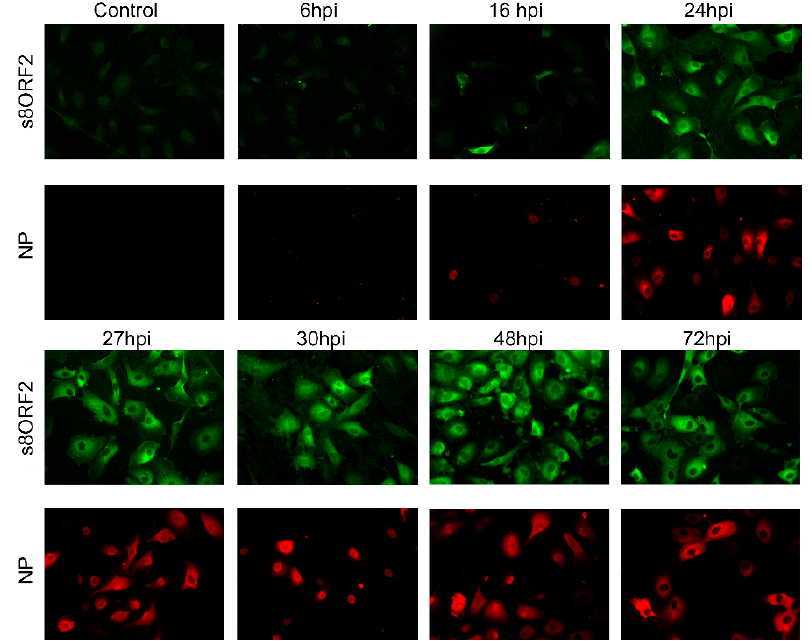
Figure 2. Subcellular localization of the s8ORF2 protein (green) and NP (red) in ISAV infected ASK cells. ISAV infected cells were immunostained separately with anti-s8ORF2 or anti-ISAV (NP) at 6, 16, 24, 27, 30, 48 and 72 h post infection (hpi). Controls are non-infected cells. Images were captured by fluorescence microscopy at 20× magnification. Viruses 2016 , 8 , x